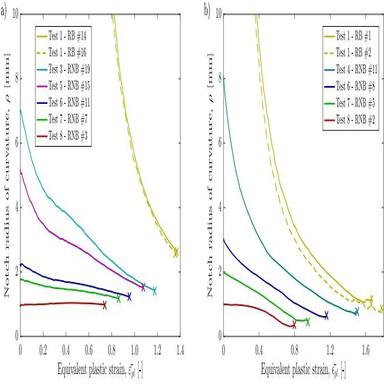
Evolution of the radius of curvature of the notch with applied equivalent plastic strain for the different RNB tensile tests: (a) stainless steel 304L; (b) copper C110.